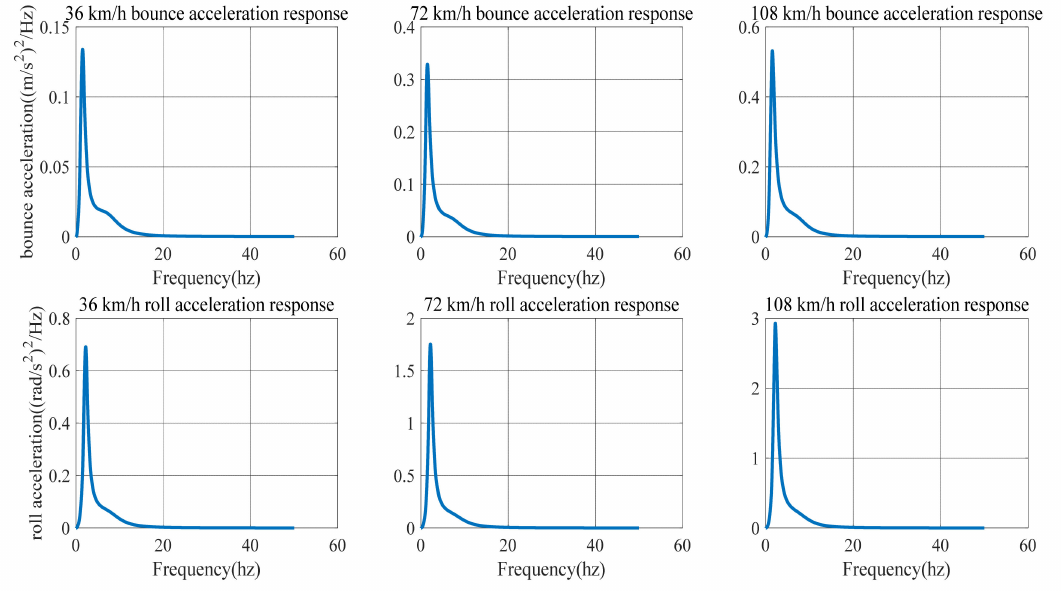
Figure 8. The power spectrum density of the bounce/roll acceleration of an HIIRS-equipped vehicle when driven at 36, 72 and 108 km/h on Class-C